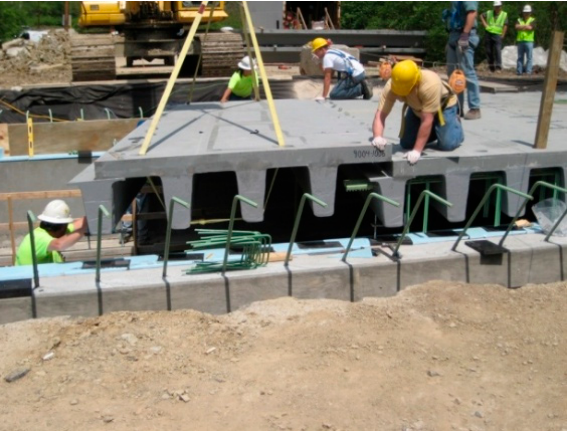
Figure 9. Installation of prefabricated elements of a SuperFiberSpan composite deck [52].